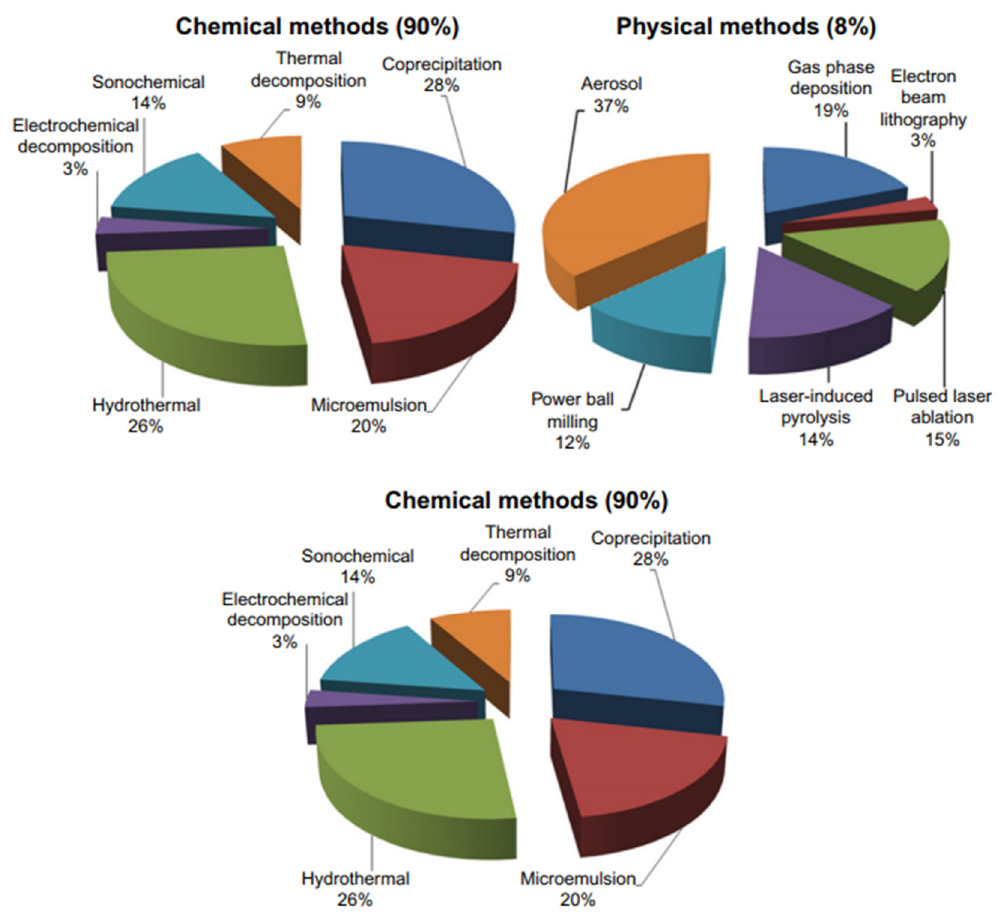
Figure 7. Relative comparison for the synthesis of iron oxide nanoparticles (IONP) by three different main categories that are further classified into different types based on sources and predominant principles. Adapted with permission from [73]. Copyright, 2016 Dovepress.